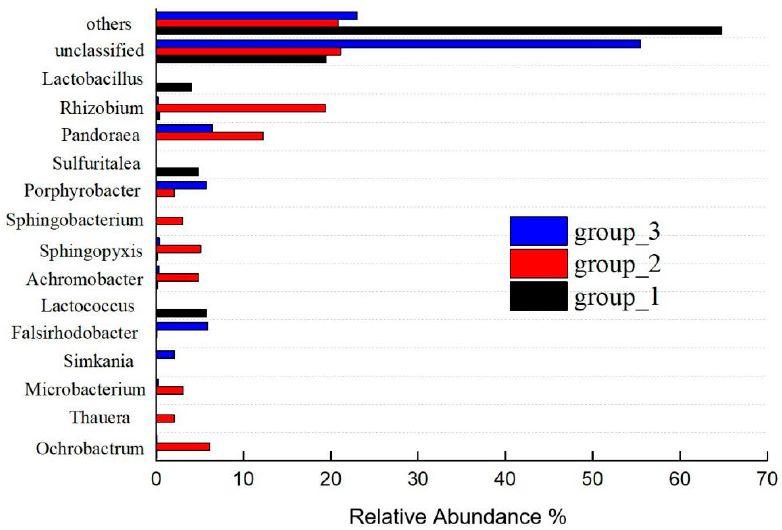
Figure 10. Relative abundance of the dominant genus in the different acclimation cycles at a genus